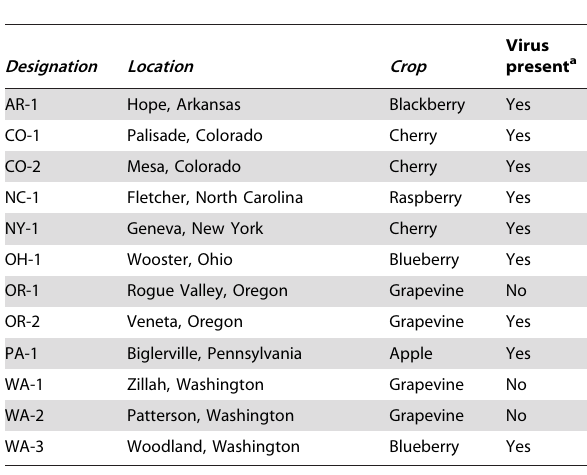
Table 1. Xiphinema americanum species complex populations included in this